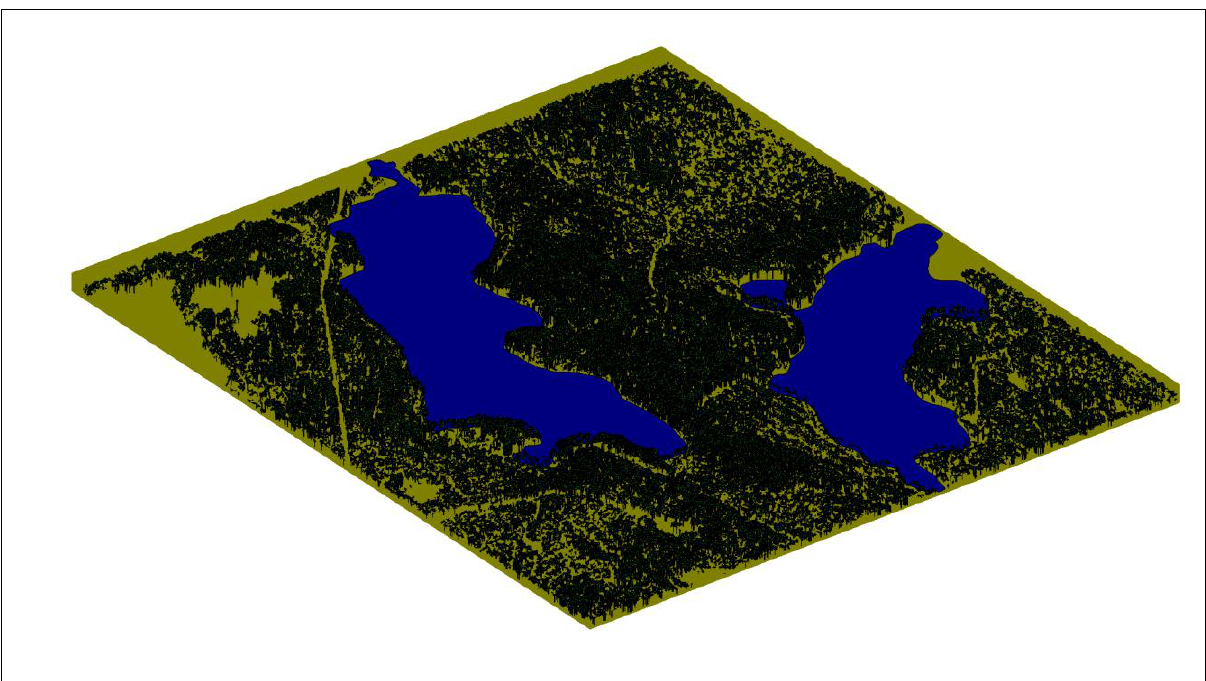
Figure 5. A visualization of a forested landscape produced by the persistent homology approach